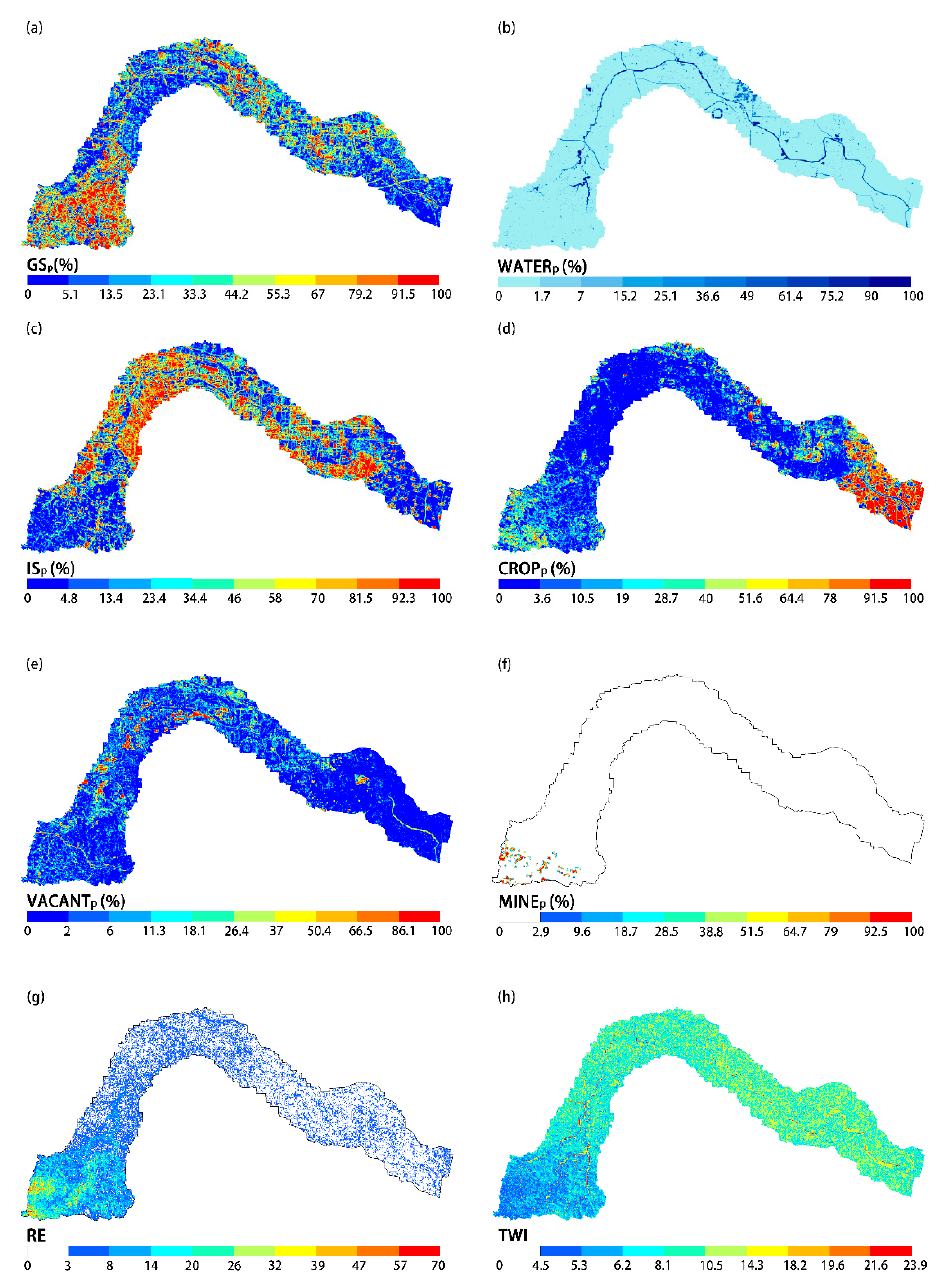
Figure 6. The spatial distribution of different landscape characteristics metrics levels along the Jialu River in greater Zhengzhou, China. ( a ) GS p (%); ( b ) WATER p (%); ( c ) IS p (%); ( d ) CROP p (%); ( e ) VACANT p (%); ( f ) MINE p (%); ( g ) RE; ( h )